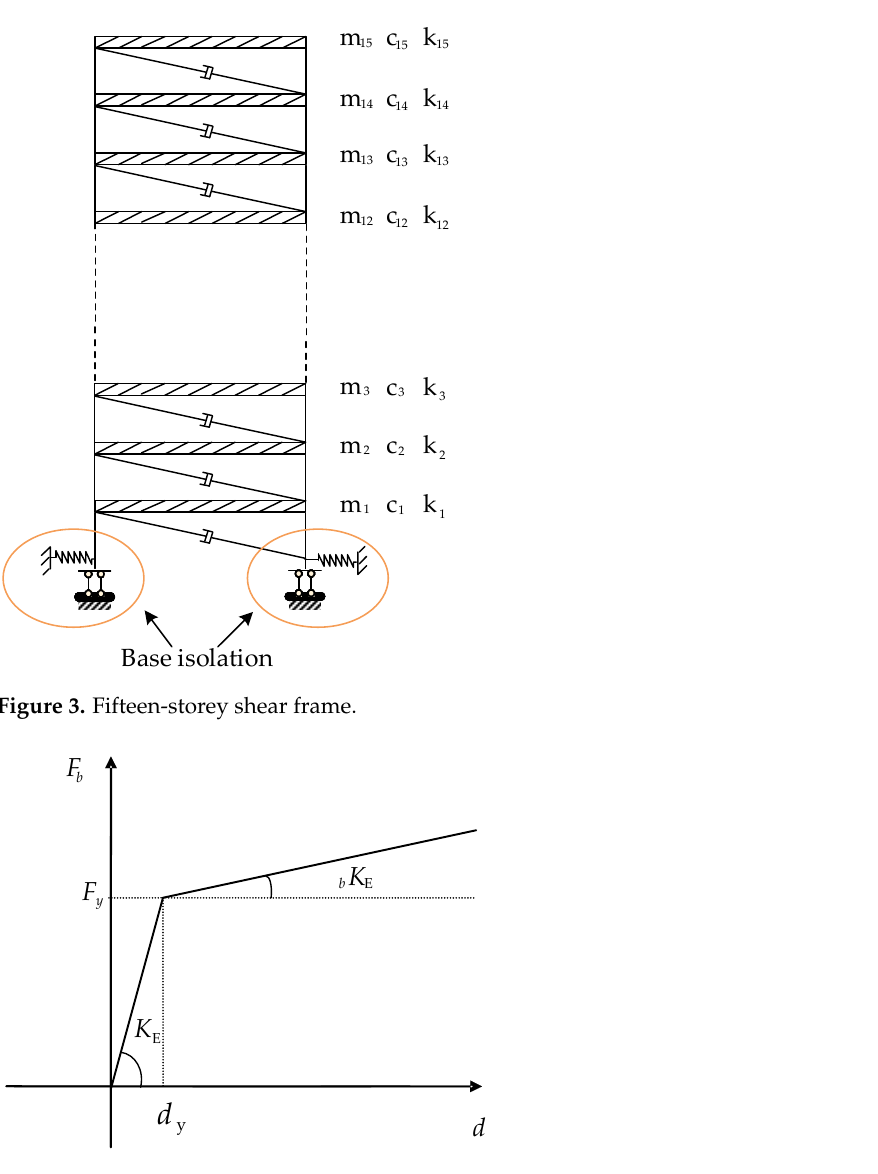
Figure 4. Relationship between force and displacement in the bilinear restoring force model. The sampling rate of measurement was 100 Hz. Six scenarios with a 10%